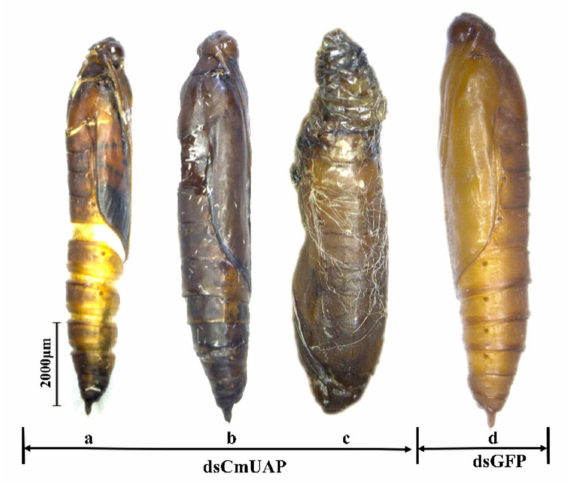
Figure 10. Abnormal morphology of C. medinalis pupae after dsRNA injection. ( a ), incomplete pupation; ( b ), darkening pupa; ( c ), no pupal shell formation; ( d ), ds GFP -injected pupa. Scale bar represents 2000 µ m.